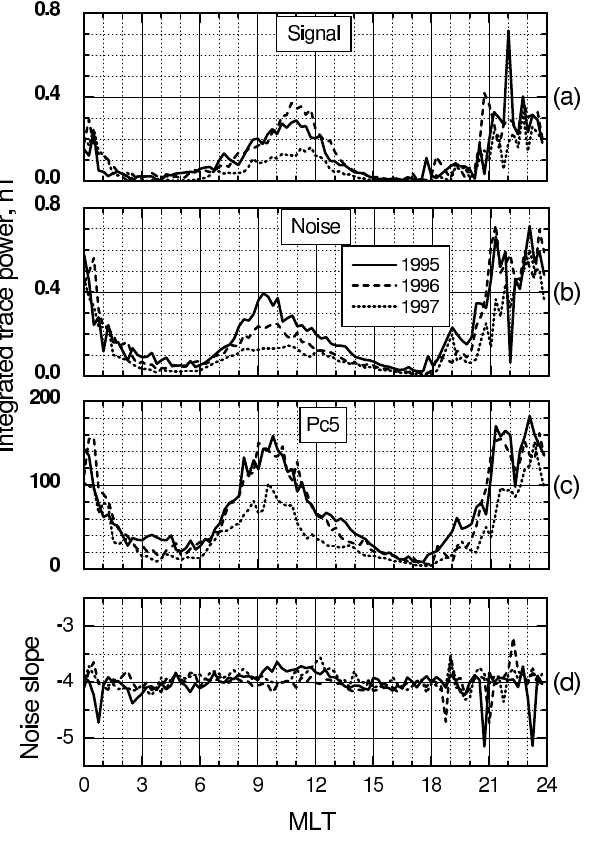
Fig. 7. Annual variations in integrated trace power at Davis over 1995–1997 (top) and corresponding frequency spectra